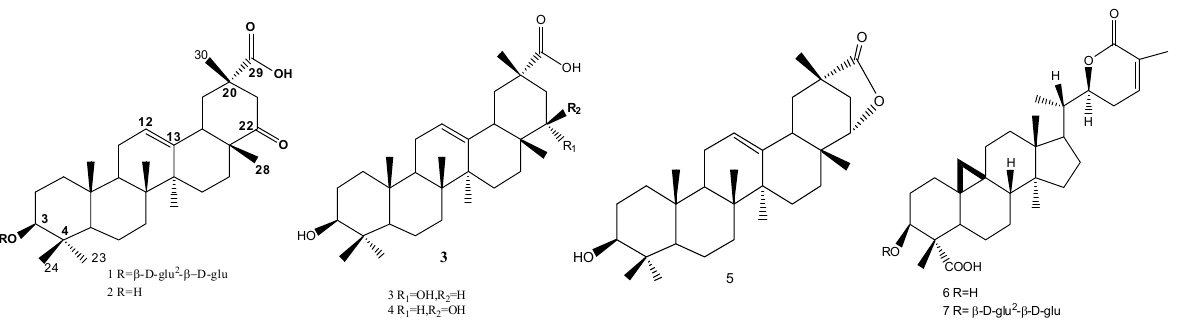
Figure 1. Structures of compounds 1 – 7